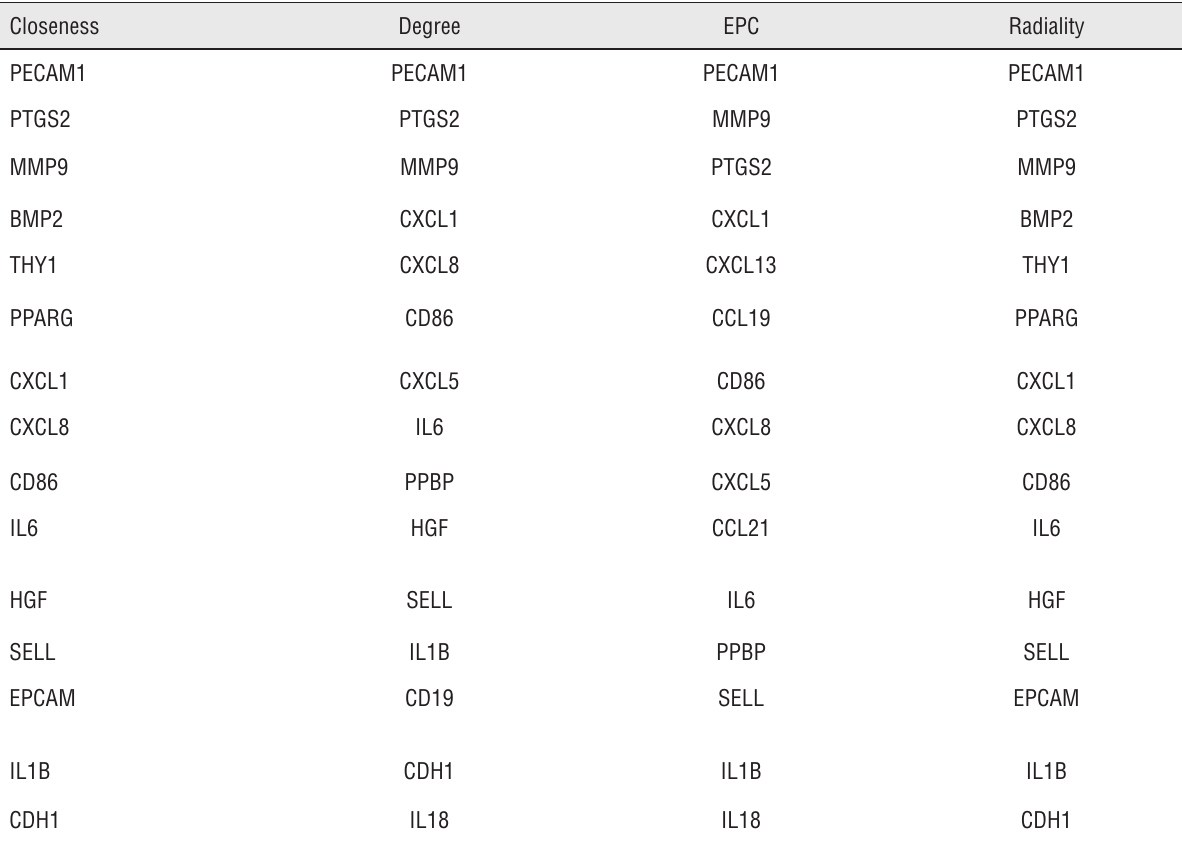
Table 3 - The top 15 hub genes resulting from each ranking method. Closeness EPC